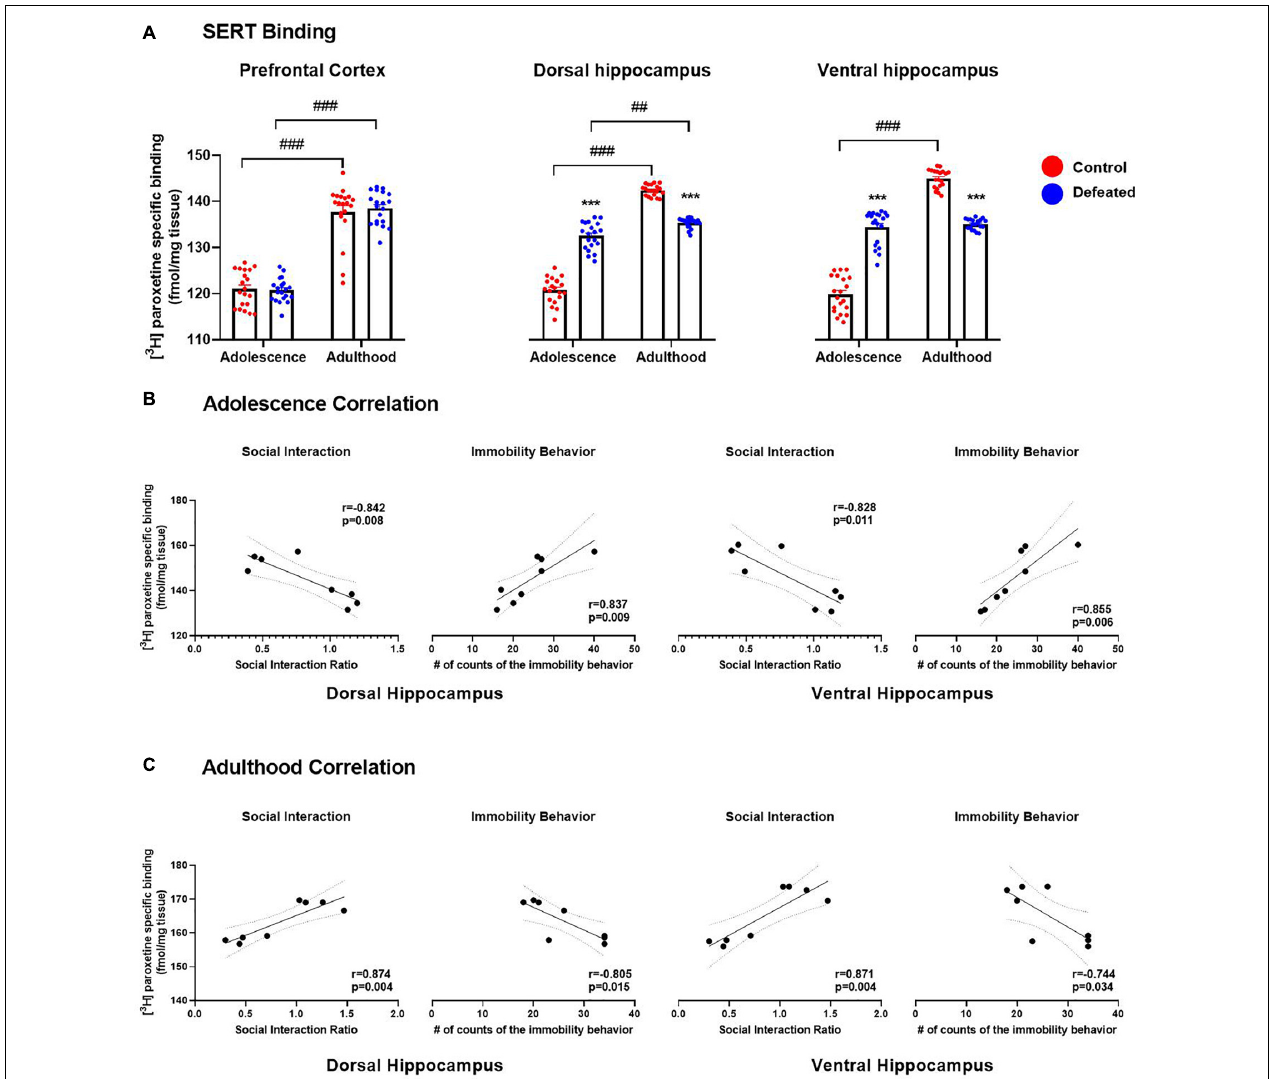
FIGURE 2 | Effects of the CSD on SERT binding (fmol/mg tissue) in the prefrontal cortex, dorsal hippocampus, and ventral hippocampus in both adolescence and adulthood (A) . Data are presented as the mean ± SEM of the [ 3 H] paroxetine specific binding (fmol/mg tissue). Two-way ANOVA, post hoc Tukey’s test *** p < 0.001 vs. control; ### p < 0.001, ## p < 0.01 vs. adulthood, n = 4. The color circles represent OD values (converted to fmol/mg tissue) for each area. Pearson correlation between SERT binding and social interaction ratio or immobility behavior in both dorsal and ventral hippocampus in adolescence (B) and adulthood (C) .